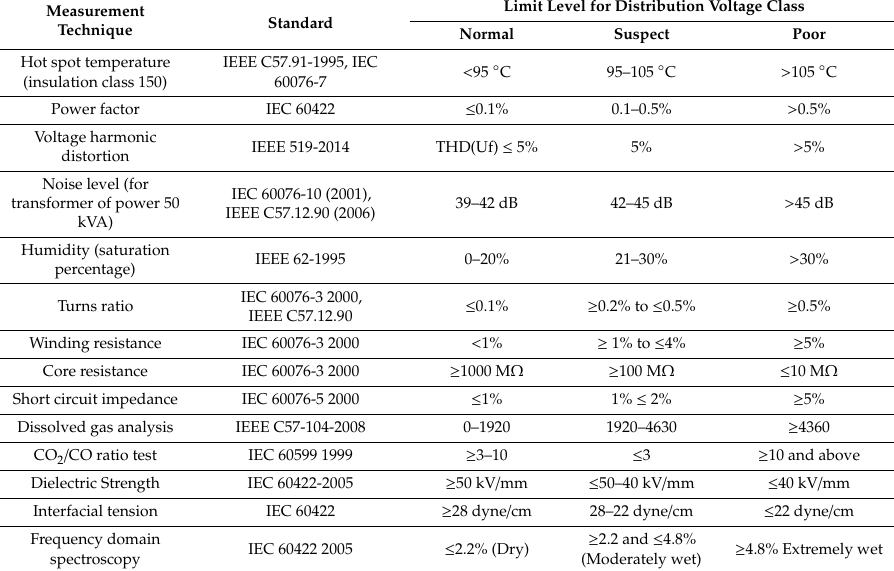
Table 2. Measurement techniques and limit levels as per